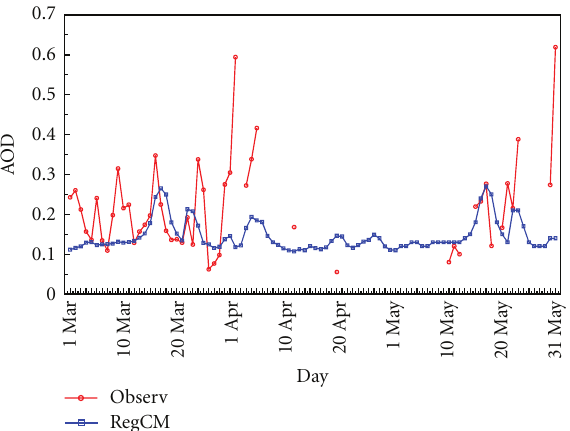
Figure 7: Daily simulated AOD values at the Ragged-point station, during March-April-May 2010 with the RegCM 4.0 and observations from